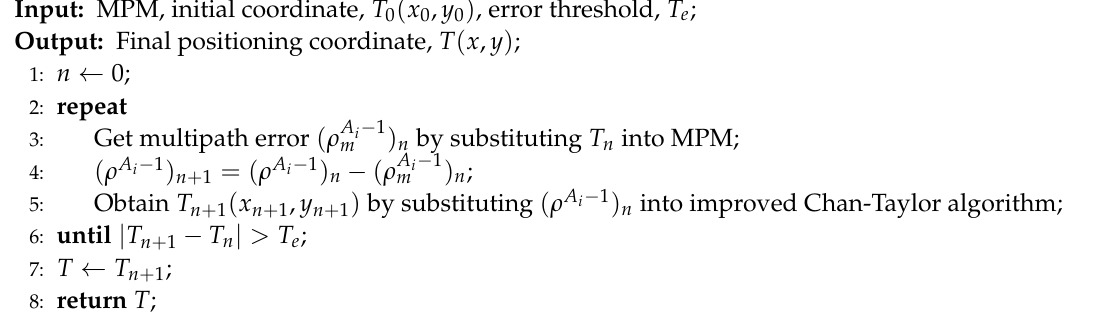
Algorithm 1 Optimization of TDOA based on